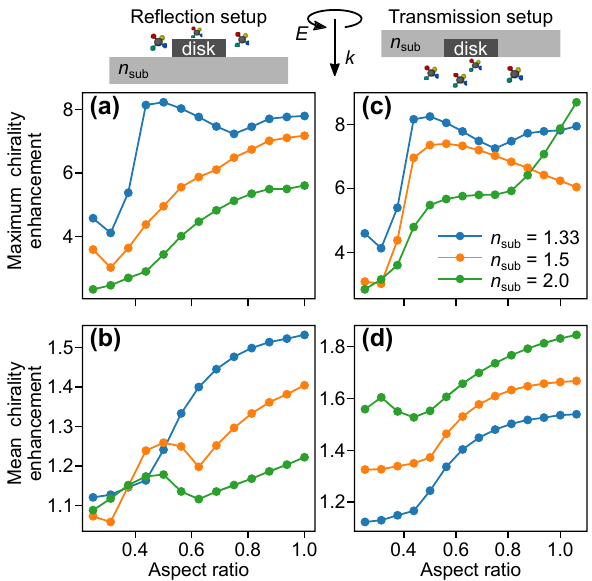
Figure 6: Chirality enhancement of a particle on a substrate. (a, c) Maximum and (b, d) mean chirality enhancement as a function of AR for varying substrate refractive index: index-matched (1.33), glass (1.5) and high-index dielectric (2) in (a, b) a reflection and (c, d) transmission configuration. Here, the statistics are taken over the upper half-space of the simulation, with the exception of index-matched case in which the both half-spaces are used (assuming that in a solution the specimen can take arbitrary position, while in the presence of a substrate, molecules cannot enter the substrate). The space occupied by the particle is always excluded from the